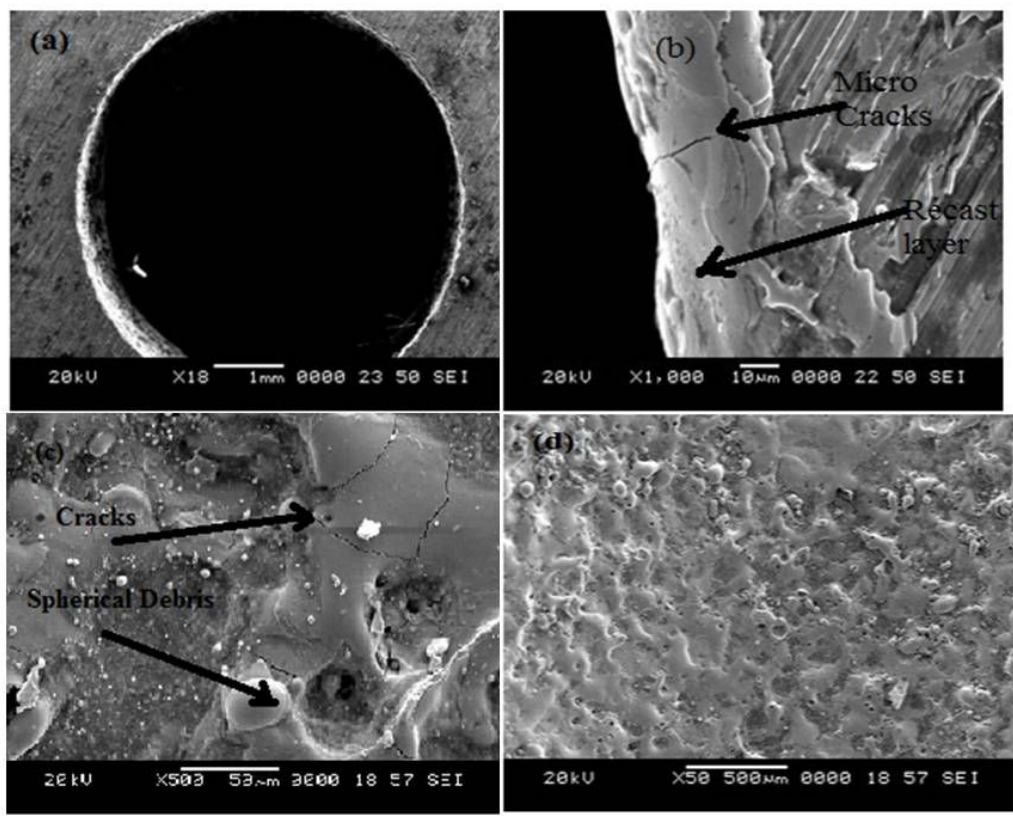
Figure 9: SEM micrograph: Exp No. 1 at; T on = 30 µ s; T off = 30 µ s; I p = 6 A